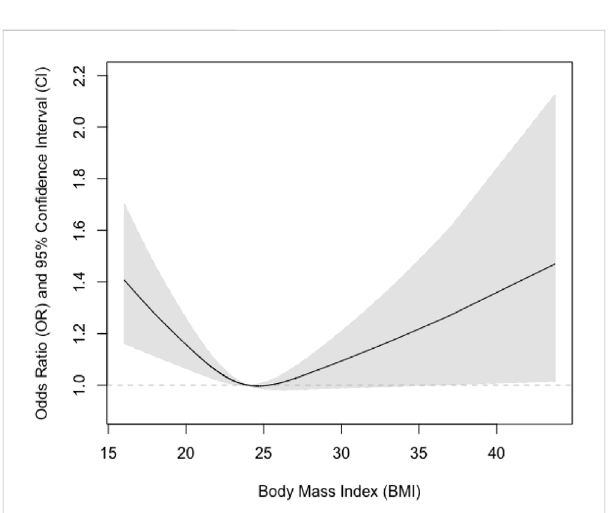
FIGURE 2 Association between body mass index and pulmonary air fl ow limitation in men.